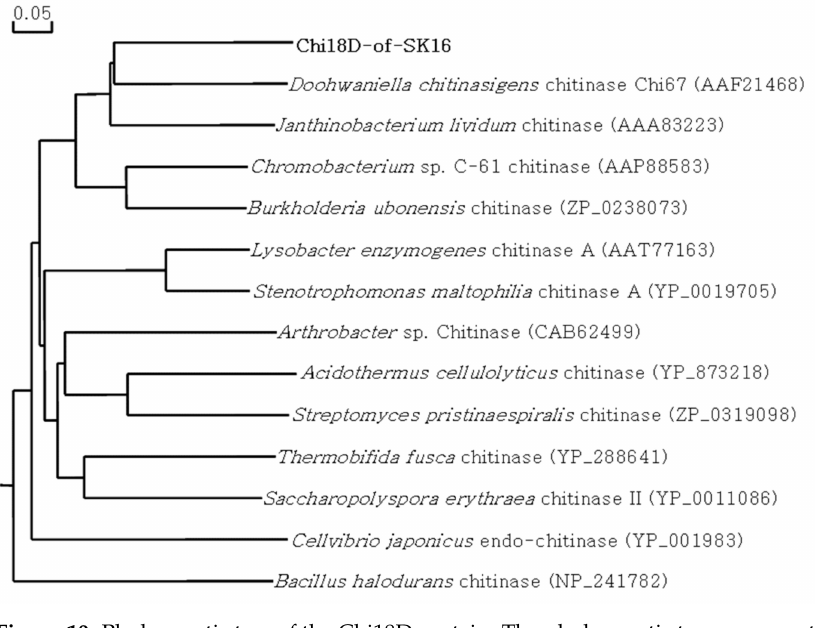
Figure 10. Phylogenetic tree of the Chi18D protein. The phylogenetic tree was constructed using the maximum likelihood method with bootstrap trials of 1000 in